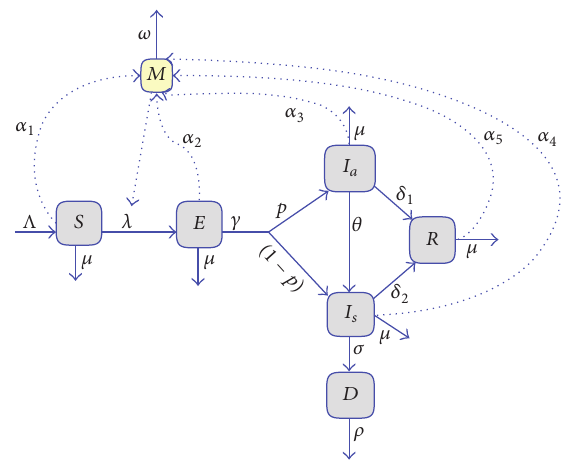
Figure 1: Flow diagram for